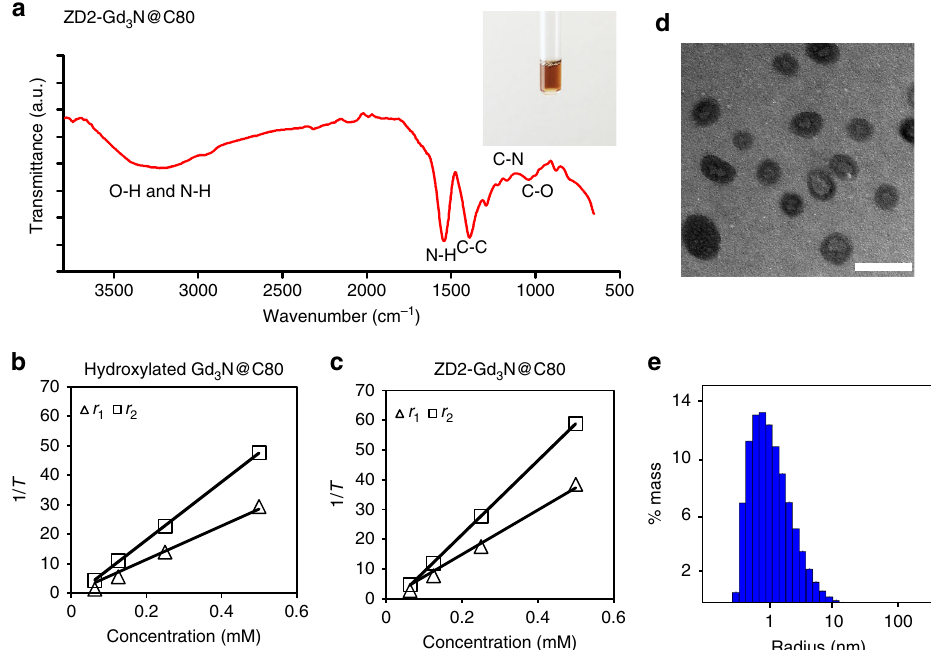
Fig. 2 Characterisation of ZD2-Gd 3 N@C80. a Fourier transform infrared spectroscopy (FTIR) of ZD2-Gd 3 N@C80. Inset : photograph of ZD2-Gd 3 N@C80 aqueous solution (0.083 mM). Plots of 1/ T 1 and 1/ T 2 vs. contrast agent concentrations for calculation of r 1 and r 2 relaxivities of b hydroxylated Gd 3 N@C80 ( r 1 = 171.3 mM − 1 s − 1 ; r 2 = 295.5 mM − 1 s − 1 ) and c ZD2-Gd 3 N@C80 ( r 1 = 223.8 mM − 1 s − 1 and r 2 = 344.7 mM − 1 s − 1 ) at 1.5 Tesla. d TEM images ( scale bar 5 nm) and e DLS size distribution of ZD2-Gd 3 N@C80 (average radius: 1.40 nm; polydispersity: